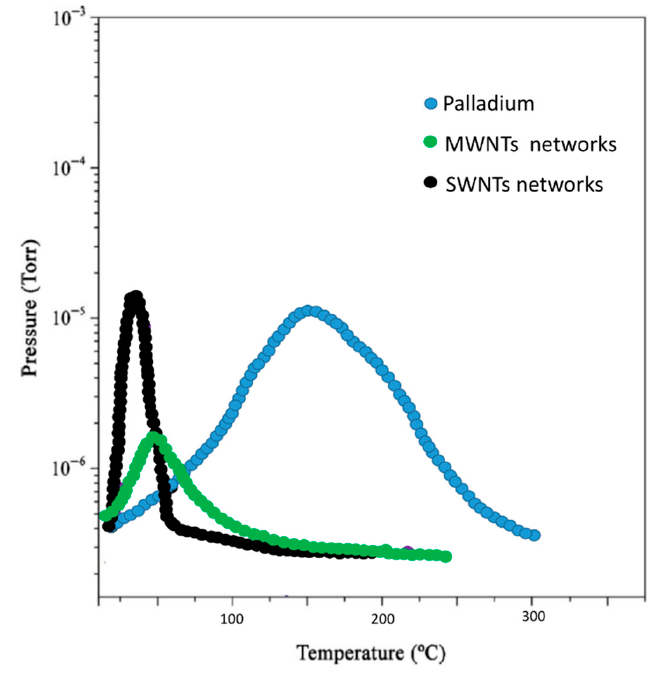
Figure 3. MB-TDS spectra were taken at a heating rate of 1 ◦